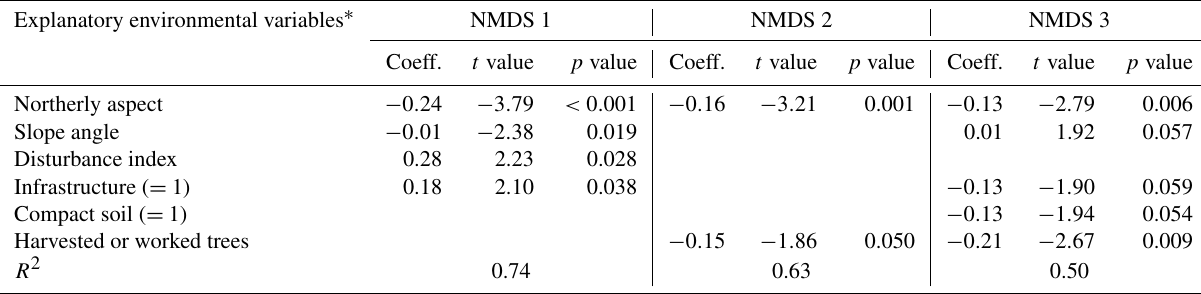
Table C1. Regression models between the three NMDS axis scores and environmental variables for canopy trees (plot layer). Only variables significant at the p < 0 . 05 level are shown. The numbers in parentheses represent the different levels of the ordinal categorical variables. Coefficients are